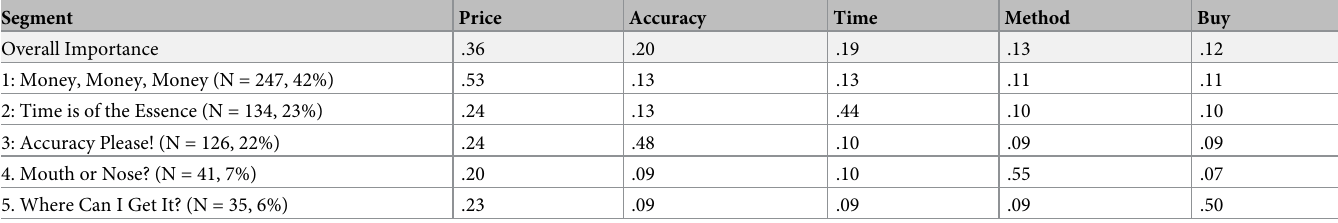
Table 5. Five segments emerged based on attribute importance �